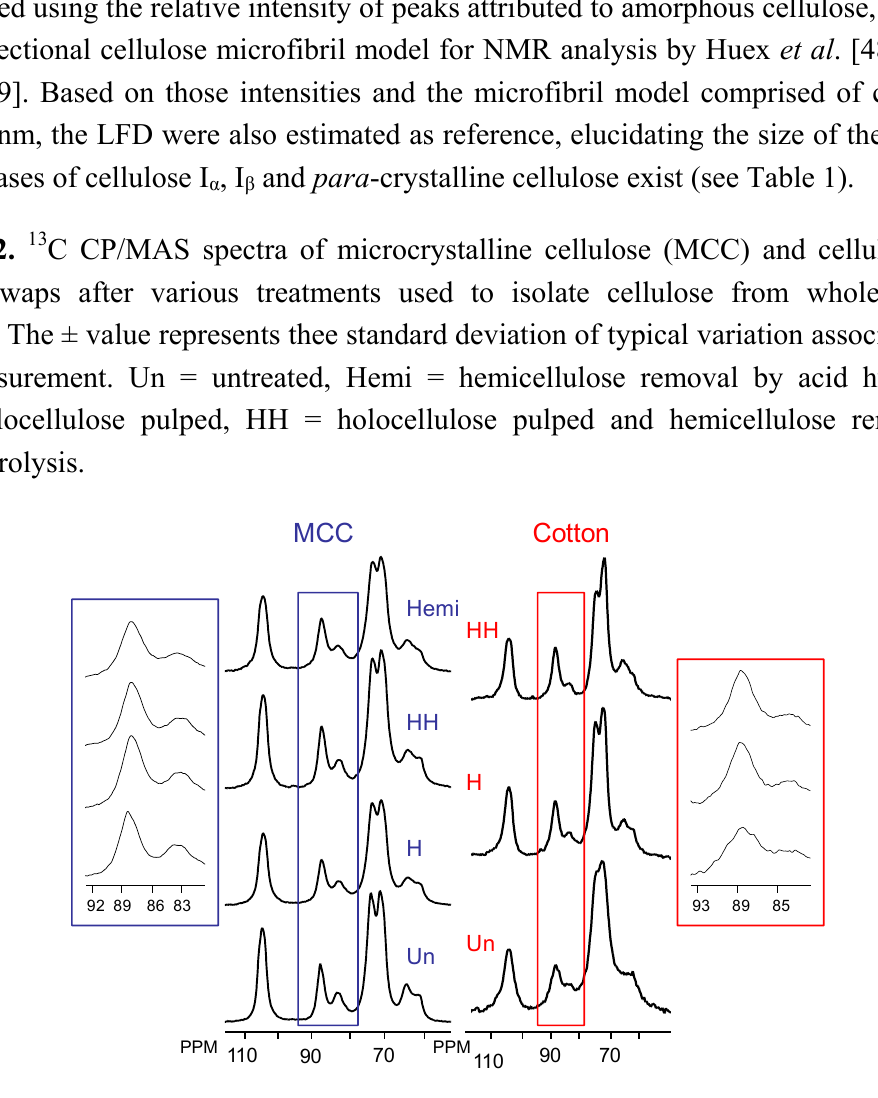
Figure 3. Non-linear line-fits of the 13 C CP/MAS spectra of untreated microcrystalline cellulose (MCC) and cellulose from cotton